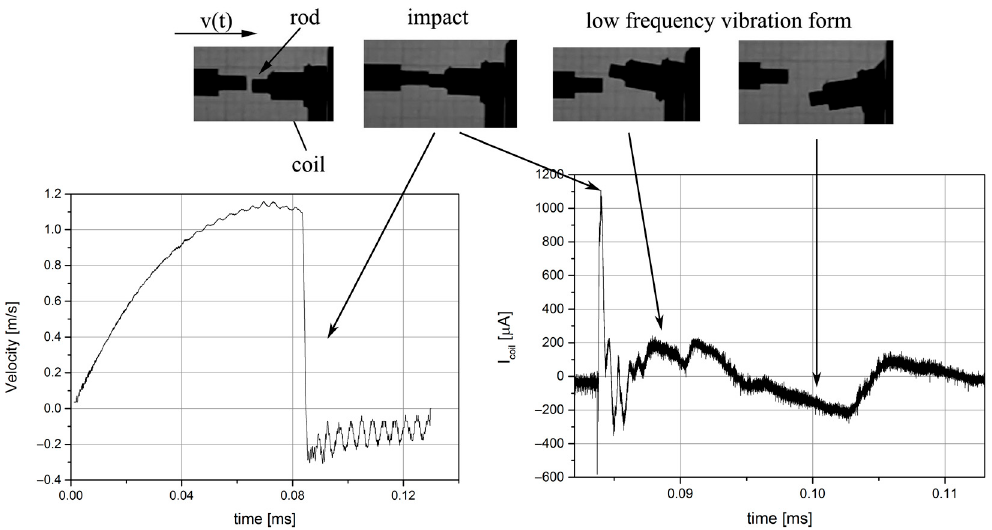
Figure 5. Impact correlated with graphs of velocity and output voltage.